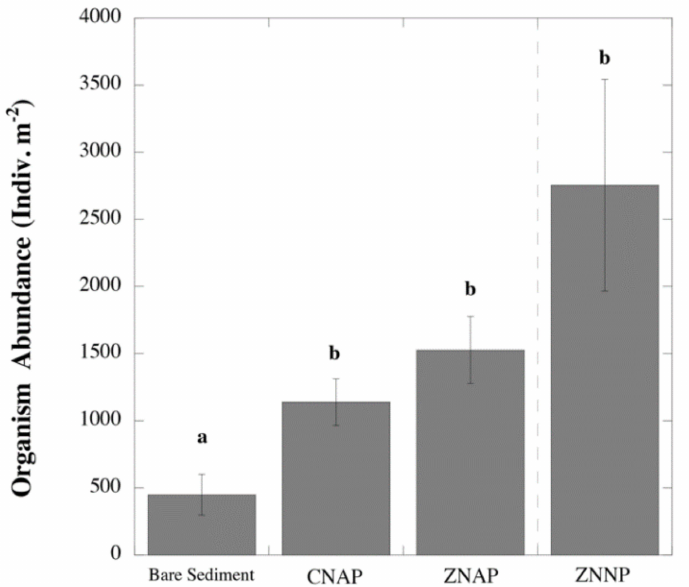
Figure 3. Organism density (indiv. m − 2 ) recorded in the different habitats: Bare sediment-BS; artificial patches of Zostera noltei -ZNAP, artificial patches of Cymodocea nodosa -CNAP, and natural patches of Zostera noltei -ZNNP. The inset letters indicate significant differences among treatments using the Tuckey test. Data are represented as mean ± SE.